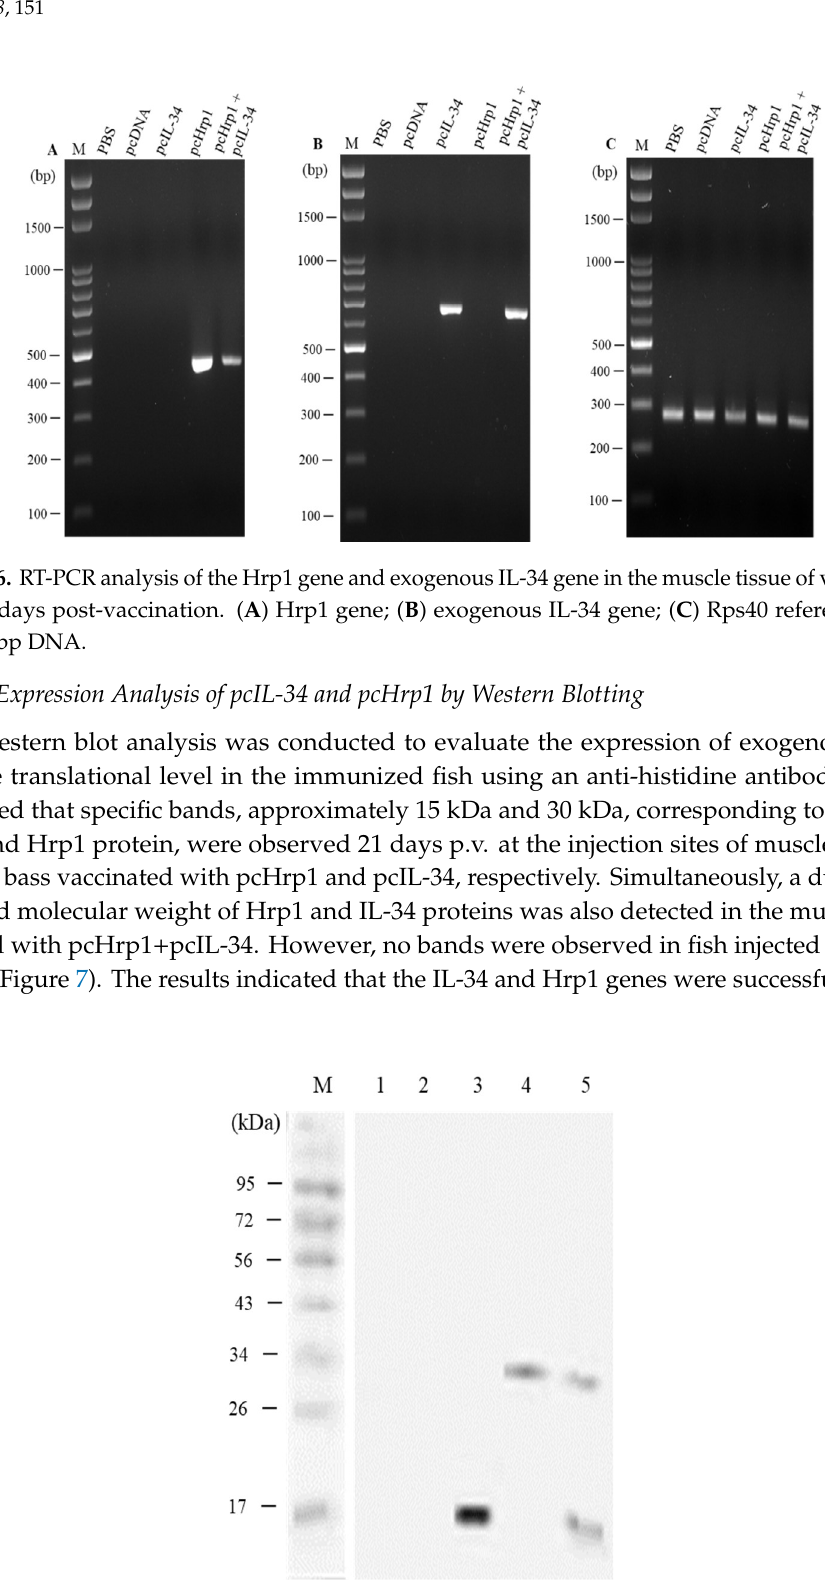
Figure 7. Western blot analysis of the transcription of pcHrp1 and pcIL-34 in immunized fish muscle tissue. M: protein ladder; lanes 1–5: muscle tissue of fish injected with PBS, pcDNA3.1, pcHrp1, pcIL-34 and pcHrp1+pcIL-34, respectively.